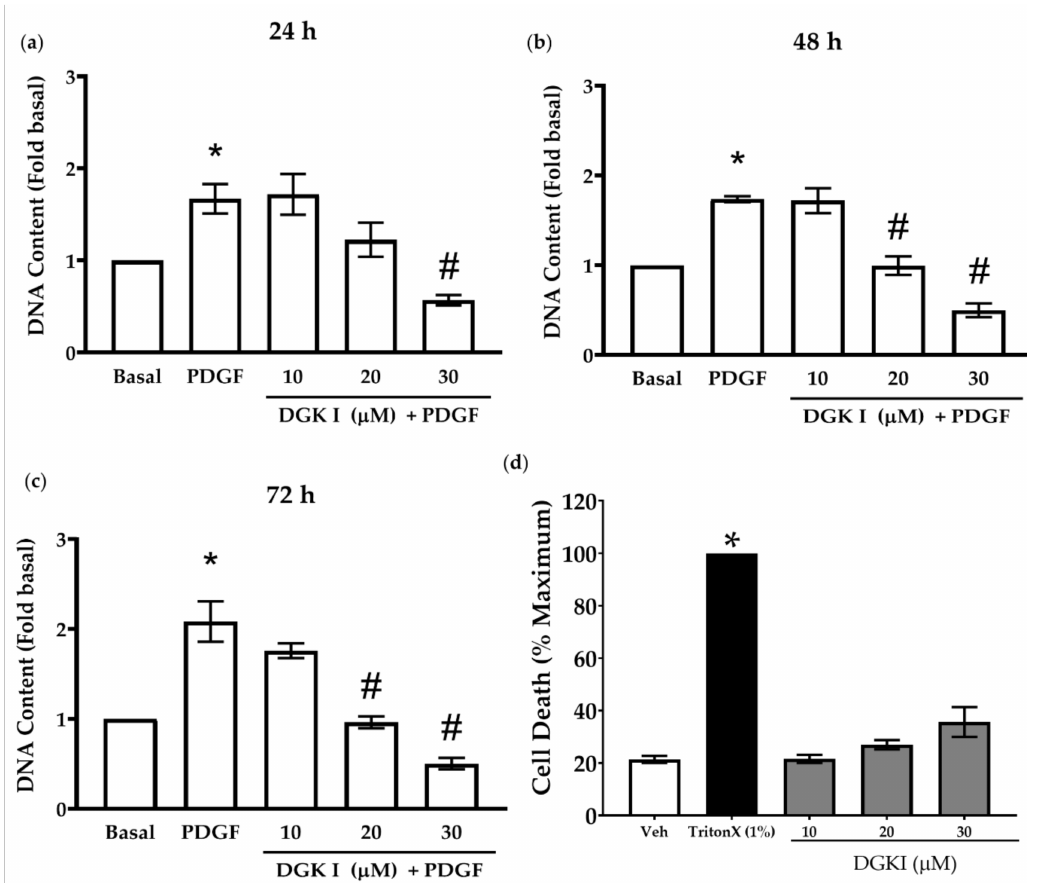
Figure 1. Effect of DGK inhibition on PDGF-induced ASM cell proliferation. Human ASM cells were treated with different concentrations of DGKI (10 µ M–30 µ M) for 15 min, followed by PDGF (10 ng/mL) stimulation for ( a ) 24 h, ( b ) 48 h, and ( c ) 72 h. Cell proliferation was assessed by measur- ing total DNA content using CyQuant assay and normalized to basal condition. Human ASM cells were treated with DGKI (10 µ M–30 µ M) for 24 h and cell viability was assessed by MTT assay ( d ). Data were normalized to maximum cell death by positive control TritonX (1%). Data above are mean ± SEM from n = 5–6 independent donors ( a – c ) and n = 3 independent donors ( d ). * p < 0.05 compared to basal, # p < 0.05 compared to PDGF using one-way ANOVA with Bonferroni post-hoc